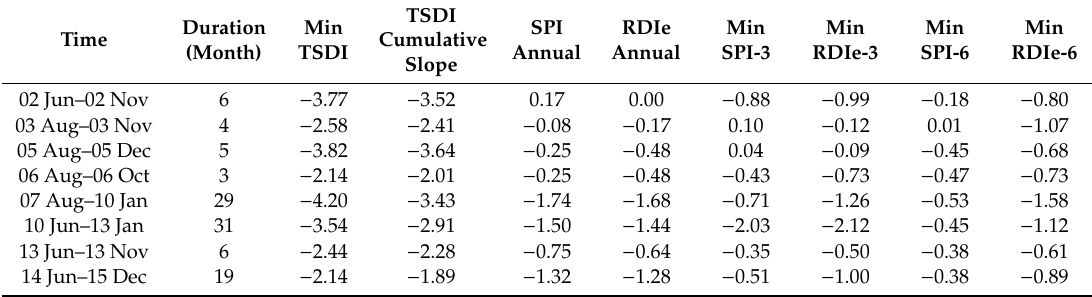
Table 6. Duration and severity of droughts in the semi-arid zone of the studied